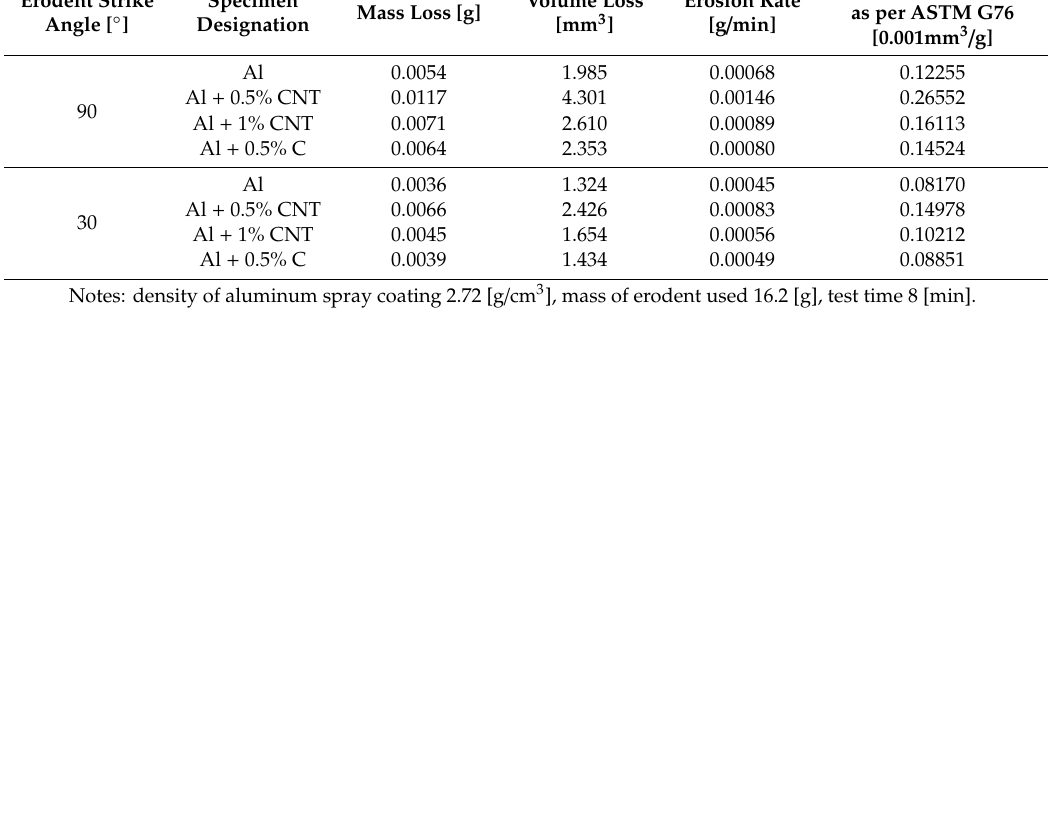
Erodent Strike Angle [ ◦